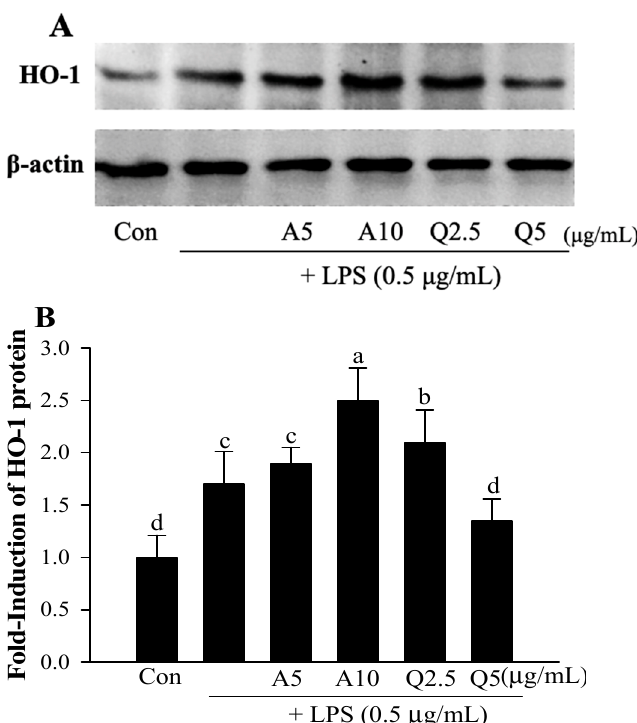
Figure 8. ( A ) Effect of Ast (A) and Que (Q) on HO-1 protein level in LPS-activated microglia. ( B ) For each sample protein content was normalized to the content of β -actin using SigmaGel software. The ratio of the expression of each protein was compared for treated and untreated controls. The values shown are the mean ± SD ( n = 3) and means labelled with different letters (a–d) within a property differ significantly as determined by Duncan’s multiple range test ( p < 0.05).